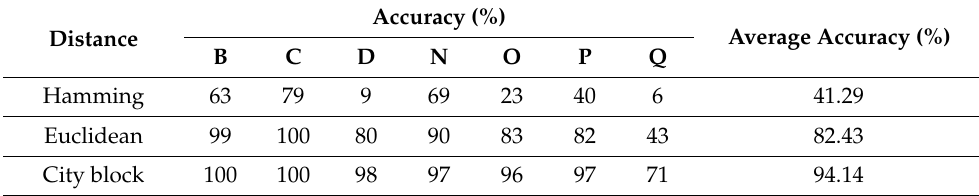
Table 4. Comparison of the results obtained using different distances with changes in facial expression.